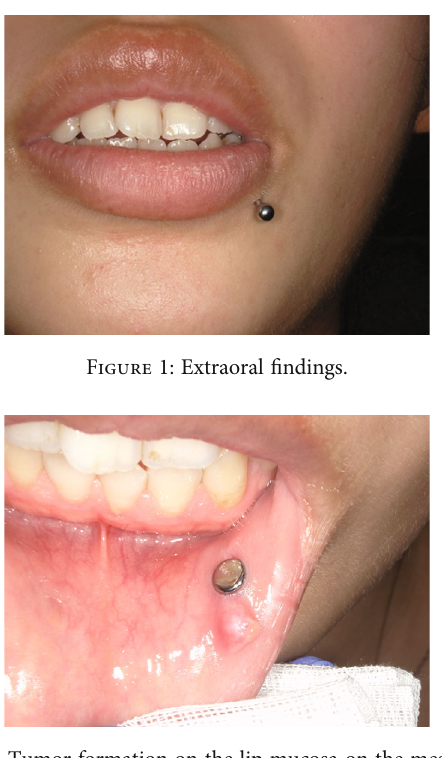
Figure 2: Intraoral fi nding. Tumor formation on the lip mucosa on the mesial side of the lip piercing.